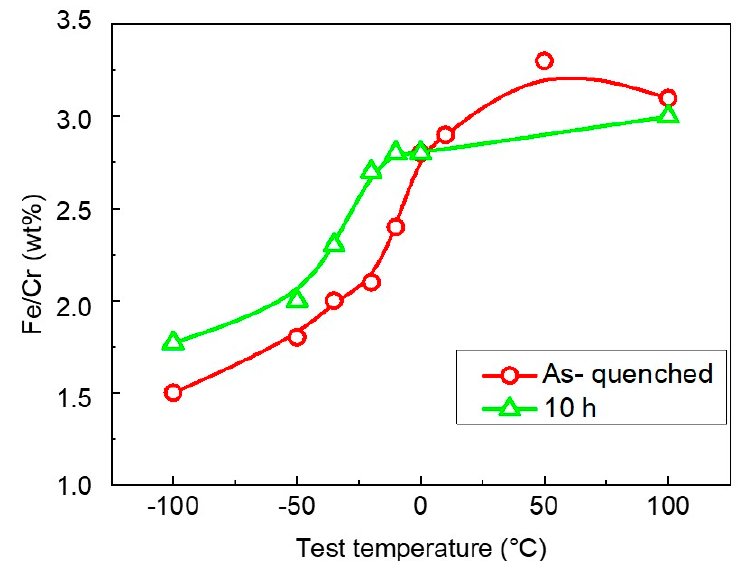
Figure 13. Fe / Cr (wt.%) vs. test temperature of Cr martensitic steel in as-quenched condition and after the heat treatment for 10 at 700 °C.